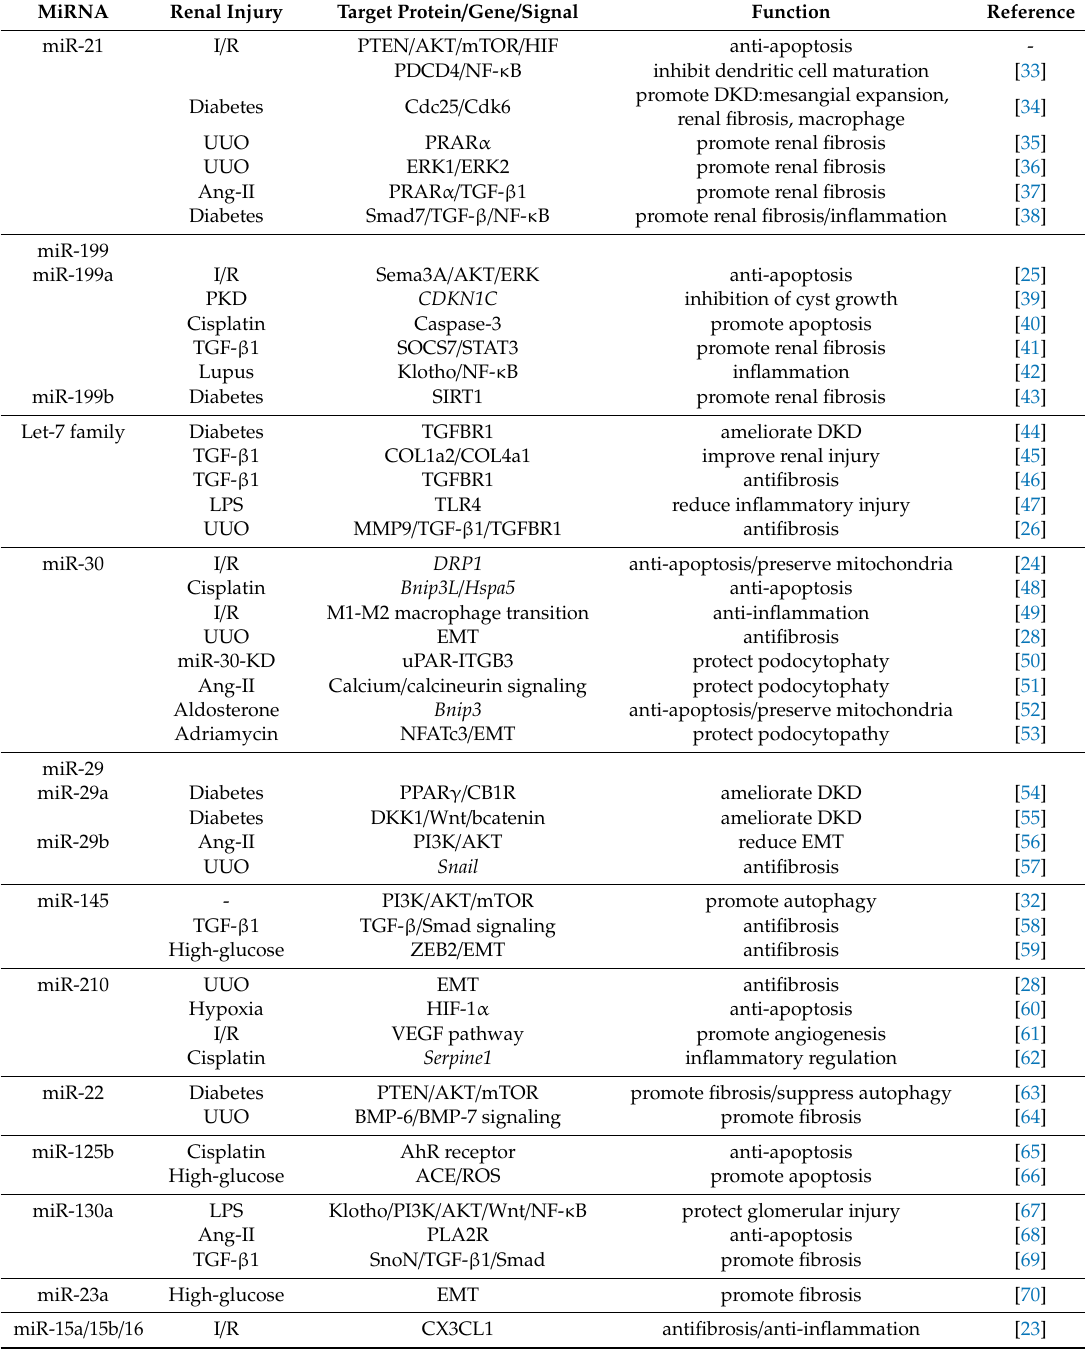
Table 2. MiRNAs in MSC-EVs in renal regeneration and